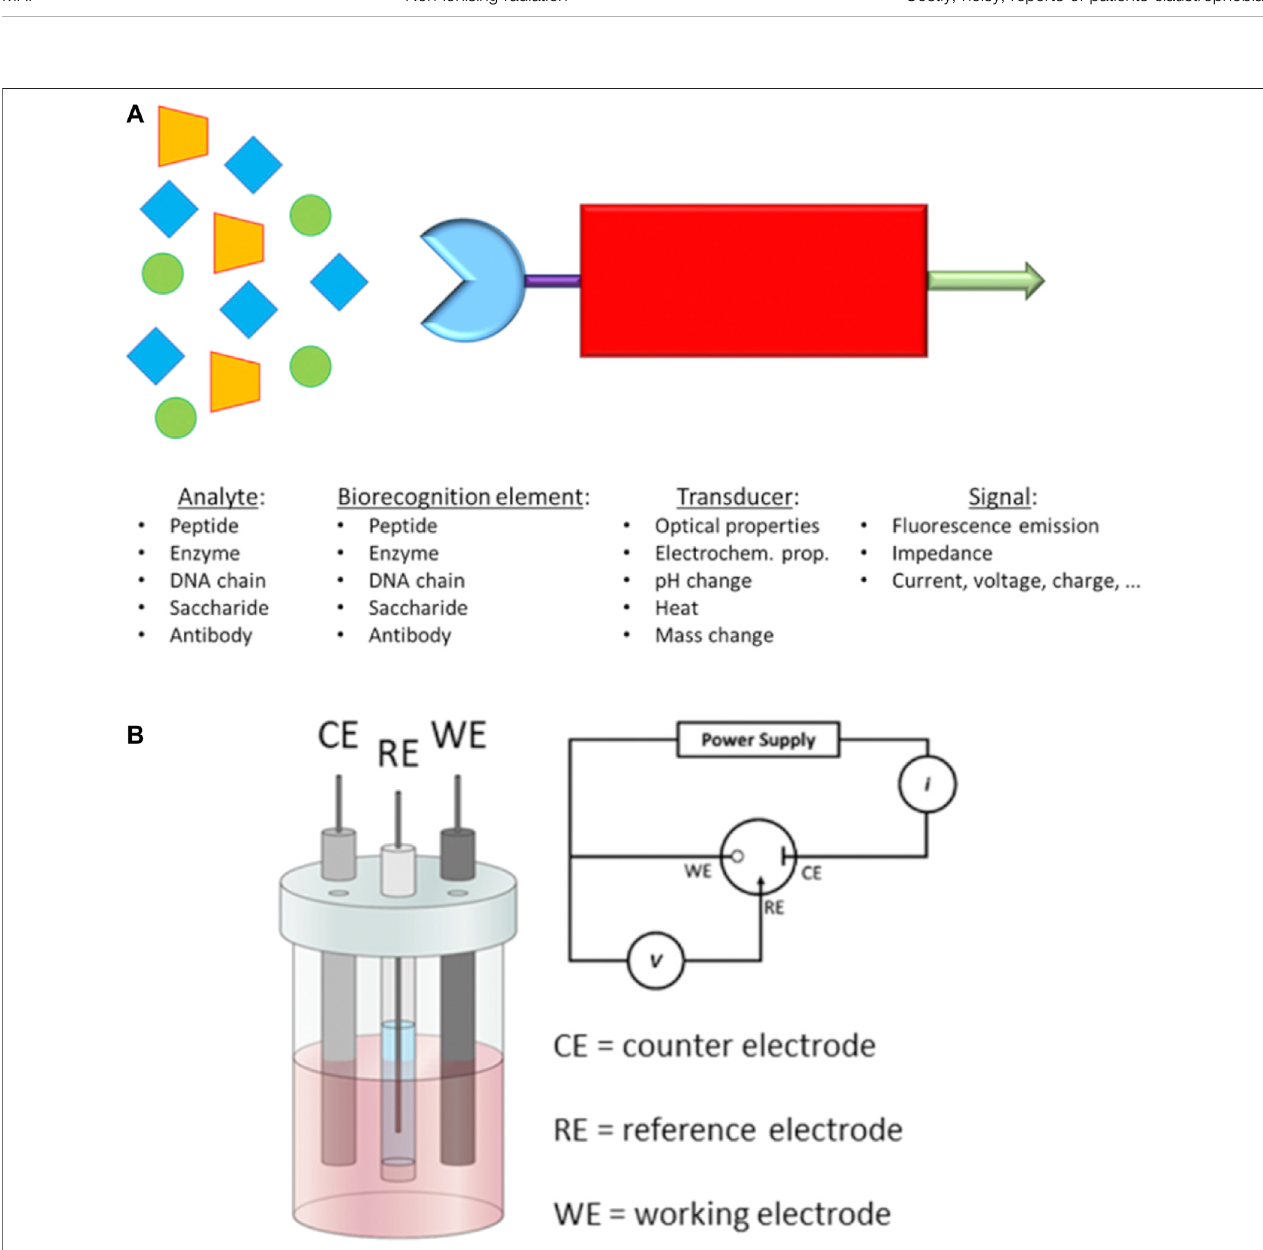
FIGURE 3 | (A) Schematic representation of a biosensor and (B) Electrochemical 3-electrodes cell and its relative electric circuit (adapted from Raccichini et al. (2019) and Fischer et al. (2009)).